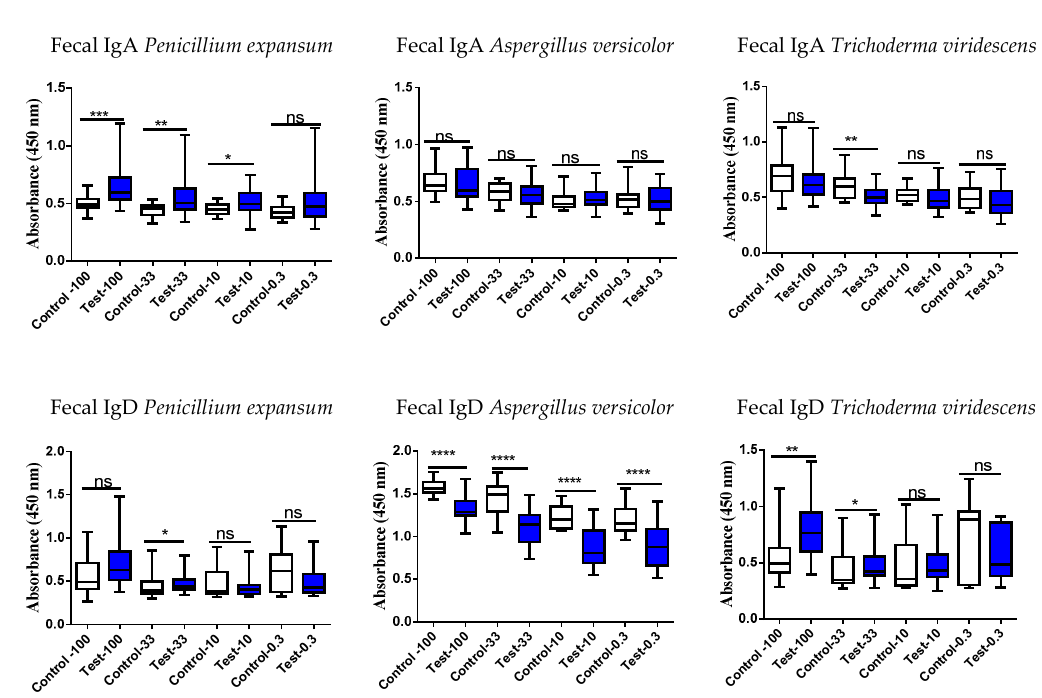
Figure 3. Fecal Ig responses against extracts of Penicillium expansum, Aspergillus versicolor , and Trichoderma viridescens. Test = exposed subjects from the target, toxic building; control = unexposed subjects. It is commonly known that IgA plays a marked role in intestinal immunology, but there were nonsignificant IgA levels against A. versicolor and T. viridescens strains. The IgG and IgD results of A. versicolor revealed markedly reduced responses in the exposed subjects. Note that the protein dilutions of the fecal samples are 100, 33, 10, and 0.3 µg/mL. Boxplots indicate median values with 95% confidence intervals; statistically significant * p < 0.05, ** p < 0.01, *** p < 0.001 and **** p < 0.0001 when the study persons were compared to controls. Ns =